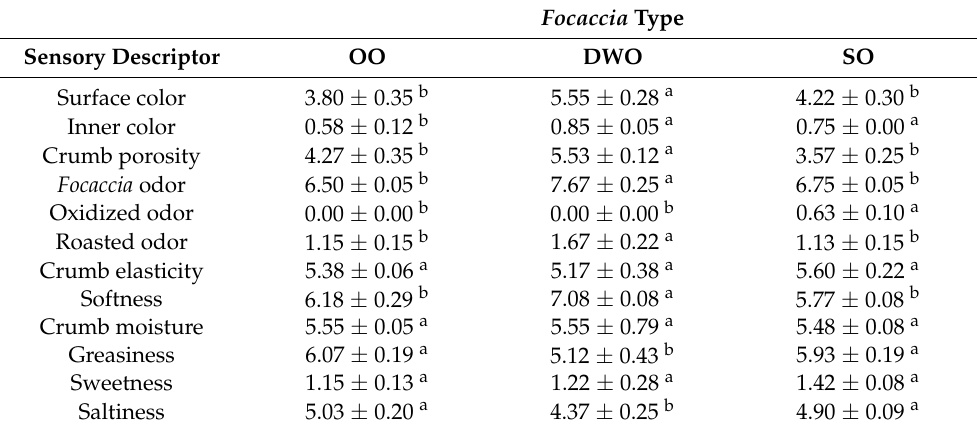
Table 7. Sensory profile of experimental focaccia . OO = focaccia prepared with olive oil; DWO =